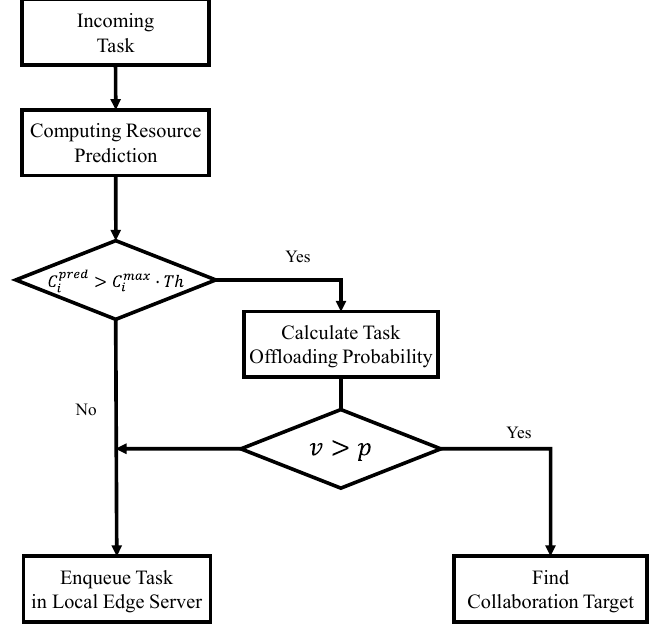
Figure 3. Flow chart of collaboration decision in the proposed scheme.